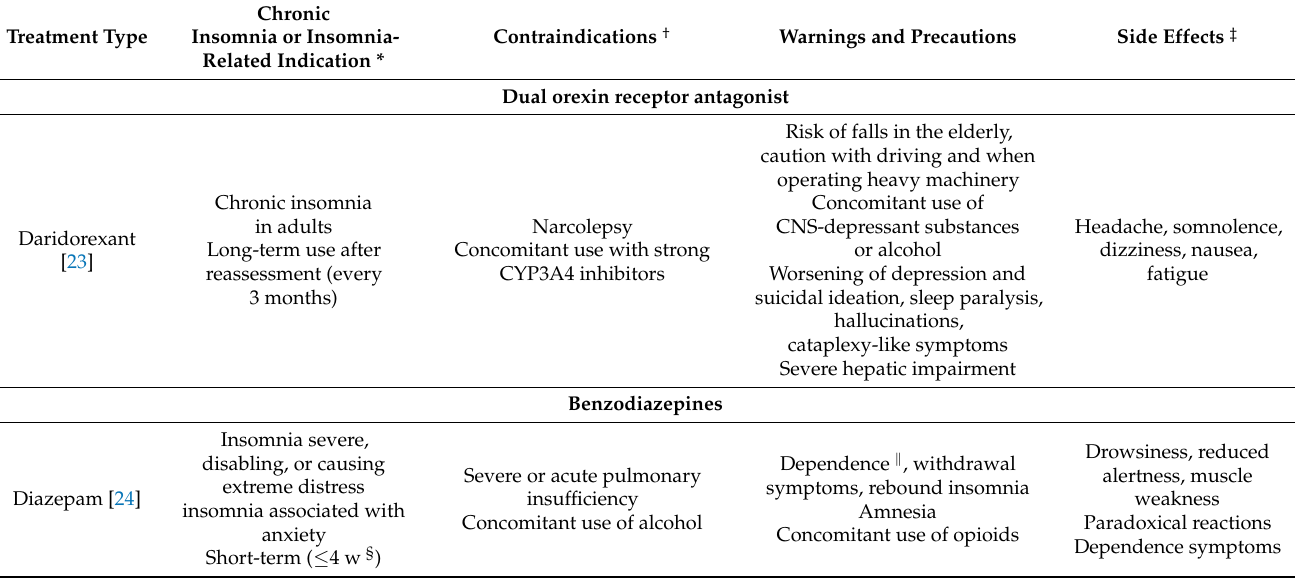
Table 1. Medicines used in Europe as pharmacological treatments for chronic